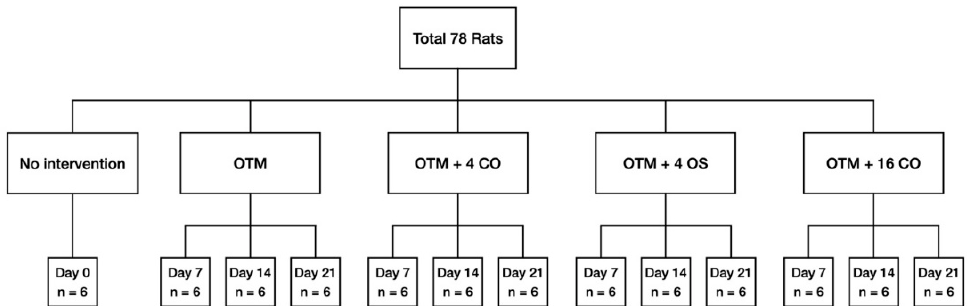
Figure 1. Flow chart representation of the distribution of the animals among the different groups and subgroups with the corresponding observation periods. OTM = orthodontic tooth movement, CO = corticotomies, OS = osteotomies.